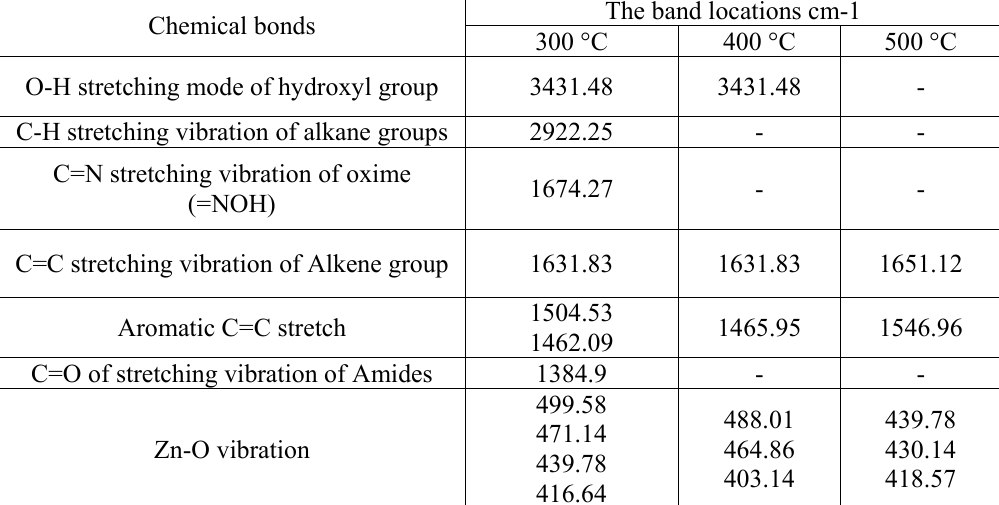
Table 4: FT-IR peaks of ZnO nanostructures.